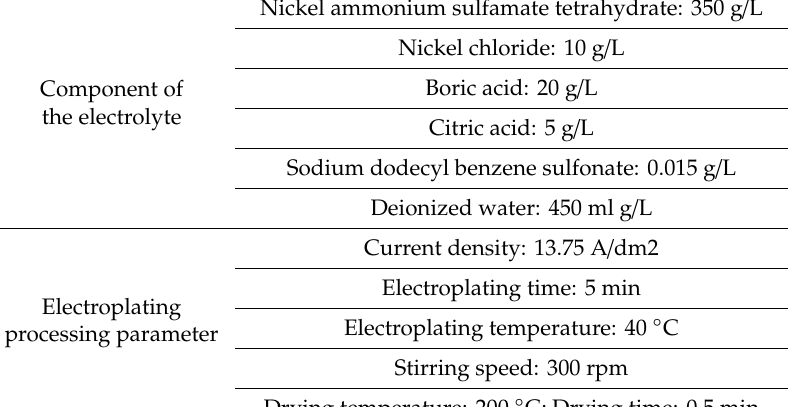
Table 3. Electroplating